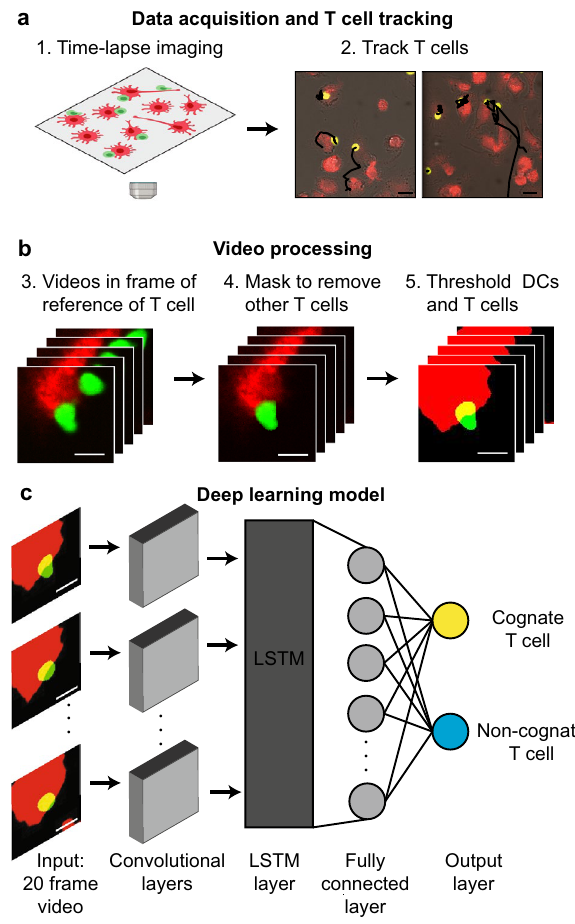
Figure 1. Schematic diagram of video processing and deep learning-based binary classifier. ( a ) Schematic of time-lapse microscopy of interacting T cells (green) and DCs (red) (created with Biorender.com) and subsequent automated T cell tracking (tracks in black). Scale bar is 20 µm. ( b ) Process to generate individual, thresholded, 101 × 101 pixel videos in the frame of reference of each T cell. Scale bar is 10 µm. ( c ) Overview of the deep learning-based binary classifier. The model consists of a feature extractor (with time distributed CNN, batch normalization and max pooling layers), LSTM model, fully connected layer, and final softmax classification layer to classify T cells as making cognate or non-cognate interactions with DCs. Scale bar is 10